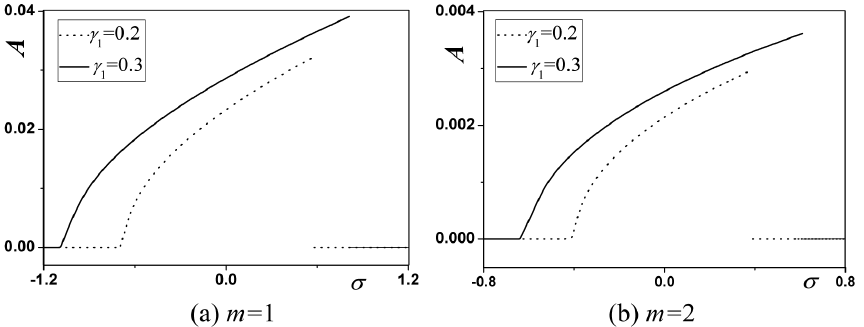
Fig. 10. Effects of the axial speed variation